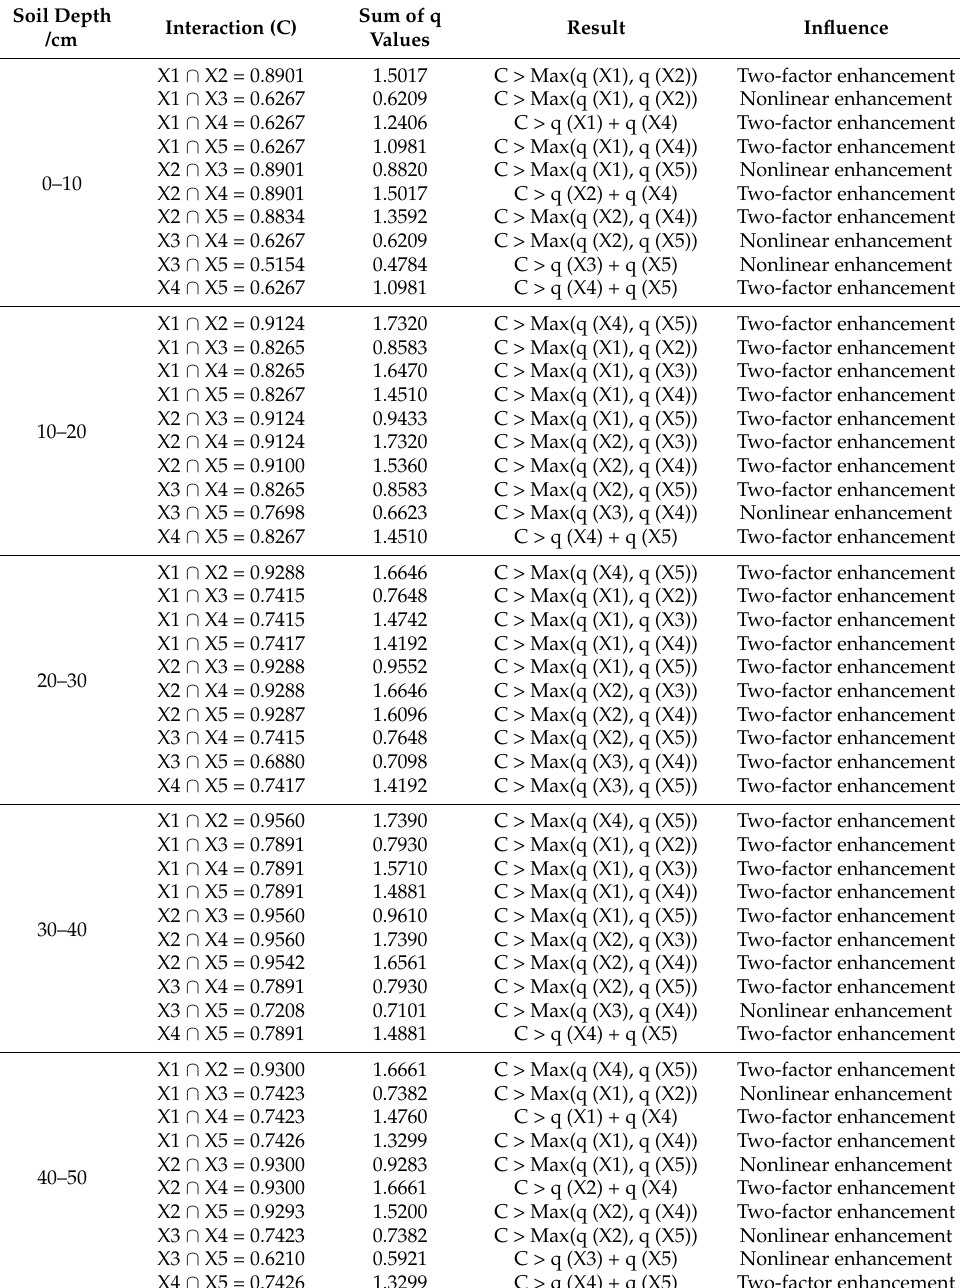
Table A1. Evaluation Factor Interaction